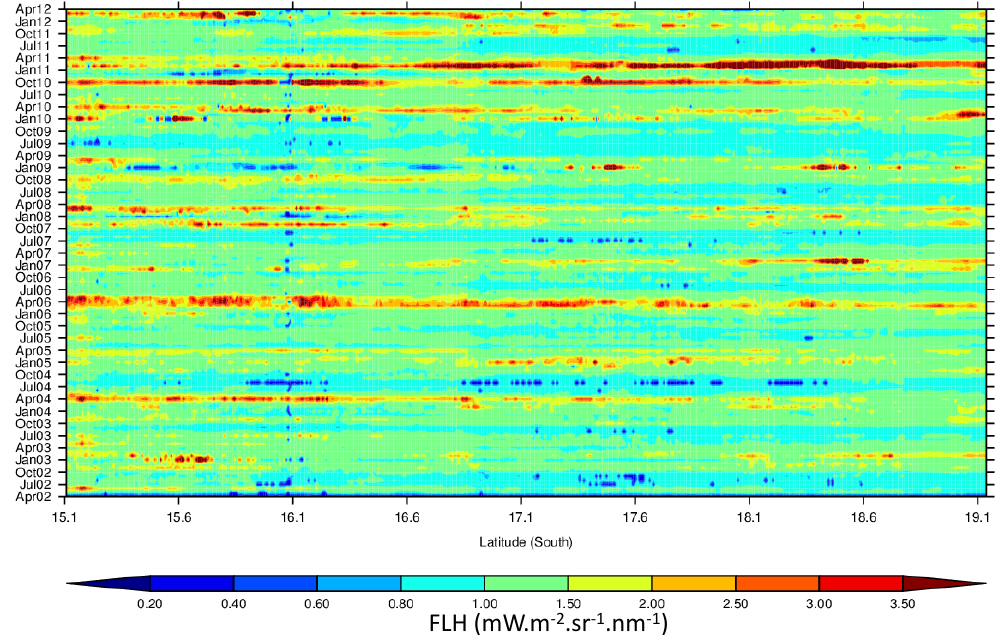
Figure 16. Latitude-time plot of FLH for the GBRW cluster.